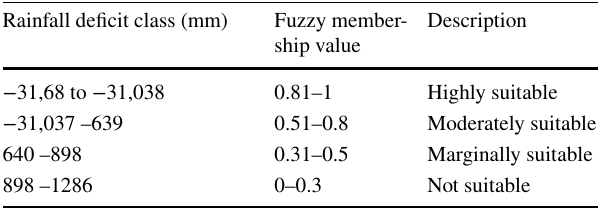
Table 8 Criteria for classification of rainfall deficit to rivers in the study